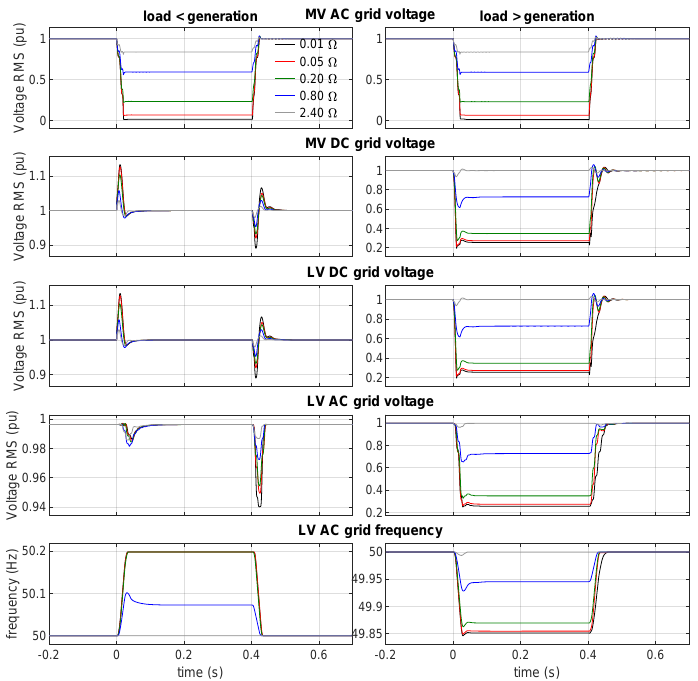
Figure 16. Voltage and frequency in the hybrid AC/DC network following balanced three-phase faults in the HV AC grid for the considered fault